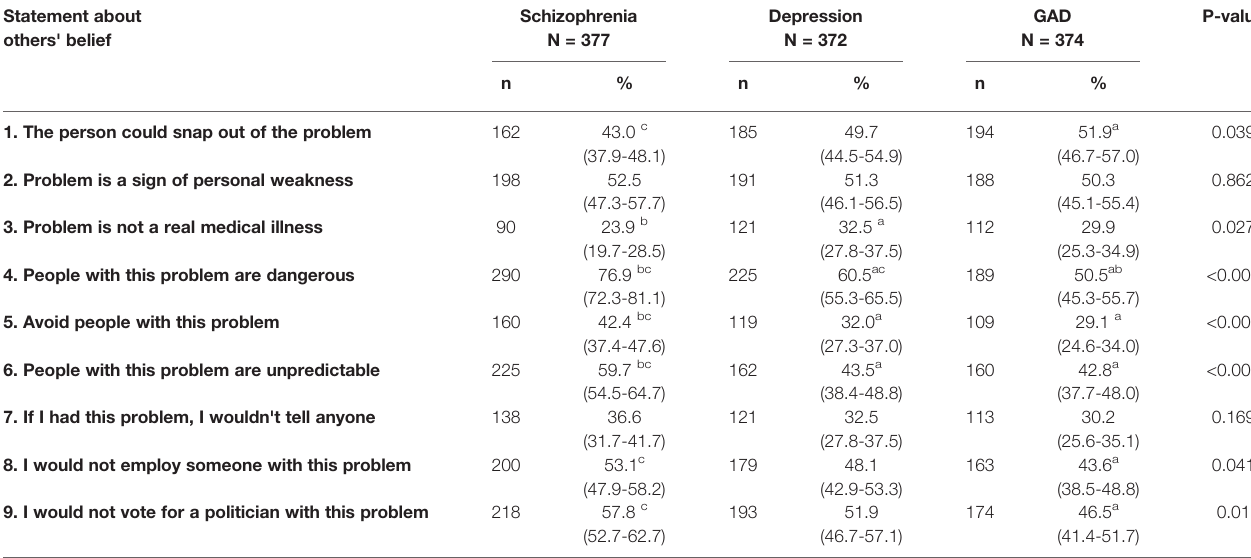
TABLE 3 | Percentage (and 95% CI) of participants who “ agree ” or “ strongly agree ” with statements about other people's attitudes towards the person in the vignette.